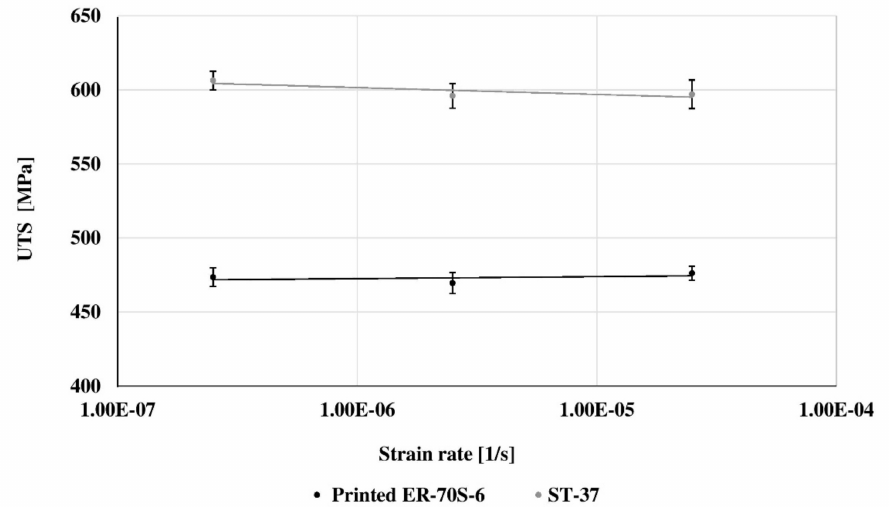
Figure 14. The e ff ect of strain rate on the ultimate tensile strength (UTS) of printed ER70S-6 alloy and reference ST-37 alloy, as obtained by SSRT.